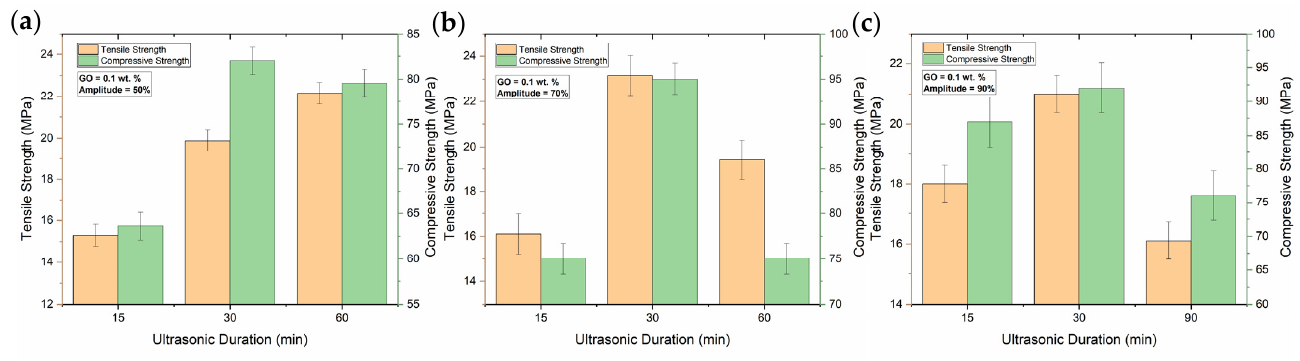
Figure 5. Mechanical properties of 3D-printed nanocomposite at ( a ) 50%, ( b ) 70%, ( c ) 90% amplitudes with varying ultrasonic duration.